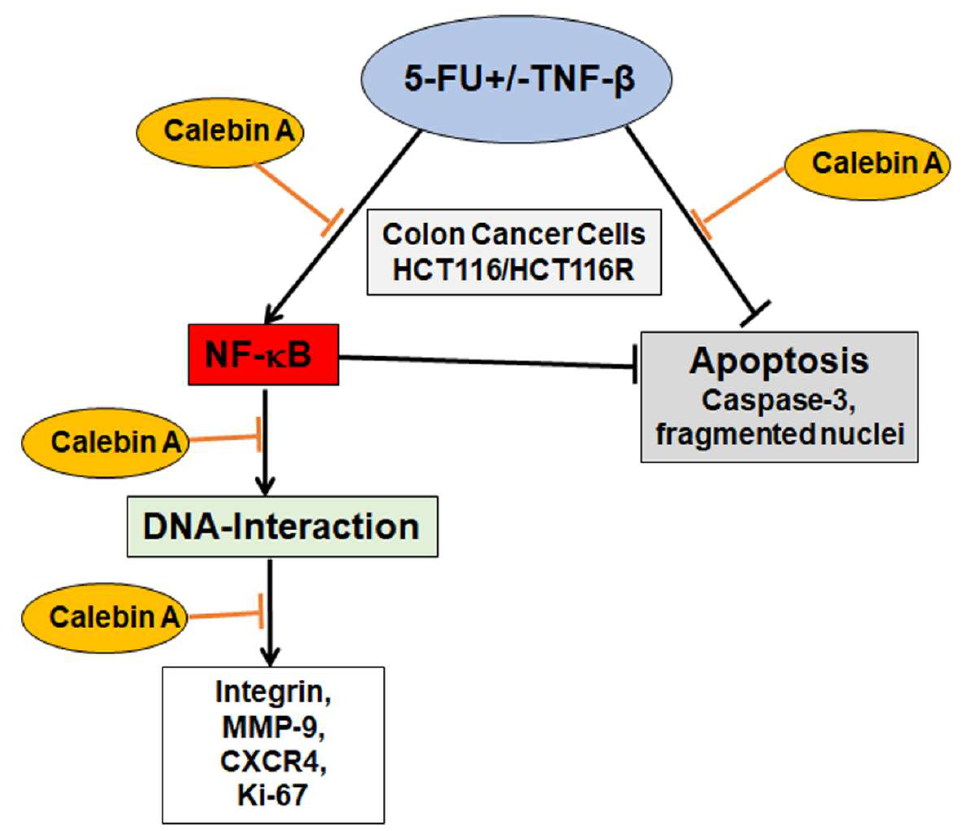
Figure 8. Working model for the modulatory and chemosensitizing e ff ects of Calebin A on the malignity of 5-FU resistant and non-resistant cells by targeting p65-NF- κ B activation in TNF- β -promoted viability of CRC cells.